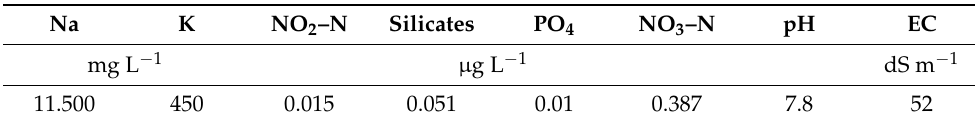
Table 1. Seawater chemical and physical